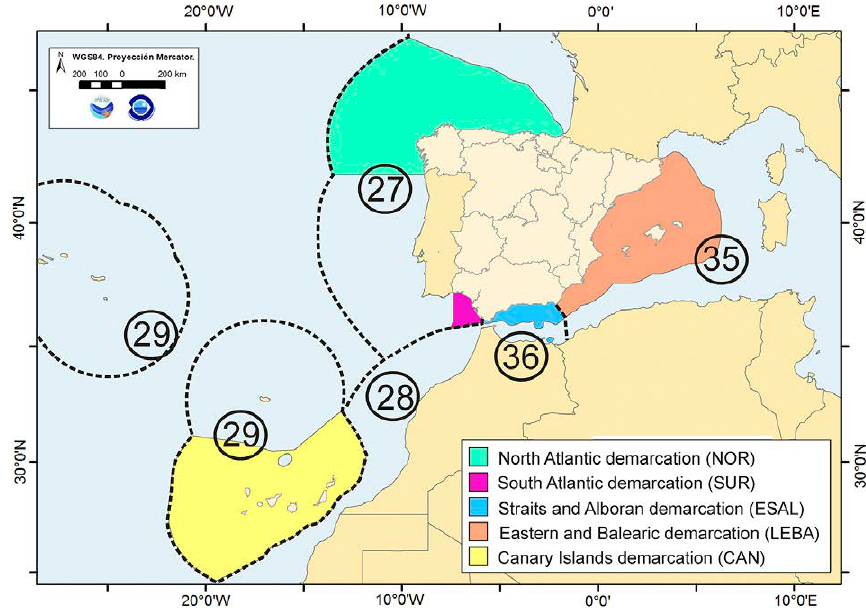
Fig. 1. – The five official demarcations of the Spanish jurisdictional waters for implementation of the Marine Strategy Framework Directive. The dashed contours and circled numbers represent the ecoregions of Spalding et al. 2007 (27, South European Atlantic Shelf; 28, Saharan Up- welling; 29, Azores-Canaries-Madeira; 35, western Mediterranean; 36, Alborán Sea; all except 36 extend further than the mapped area). Back- ground map of Spanish marine demarcations (MSFD DIRECTIVE 2008/56/EC) courtesy of Olvido Tello, Instituto Español de